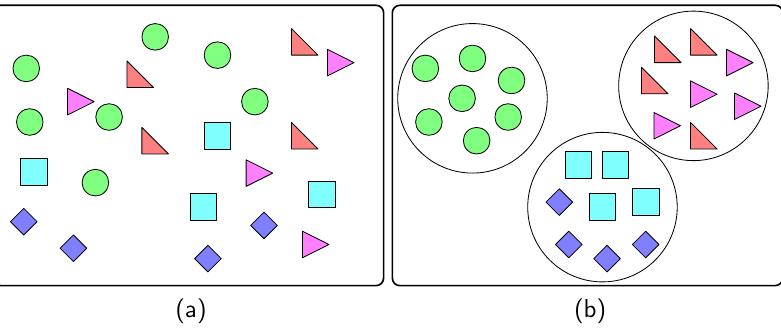
Figure 3. Data ( a ) before the partition and ( b ) after the partition with k -means clustering.